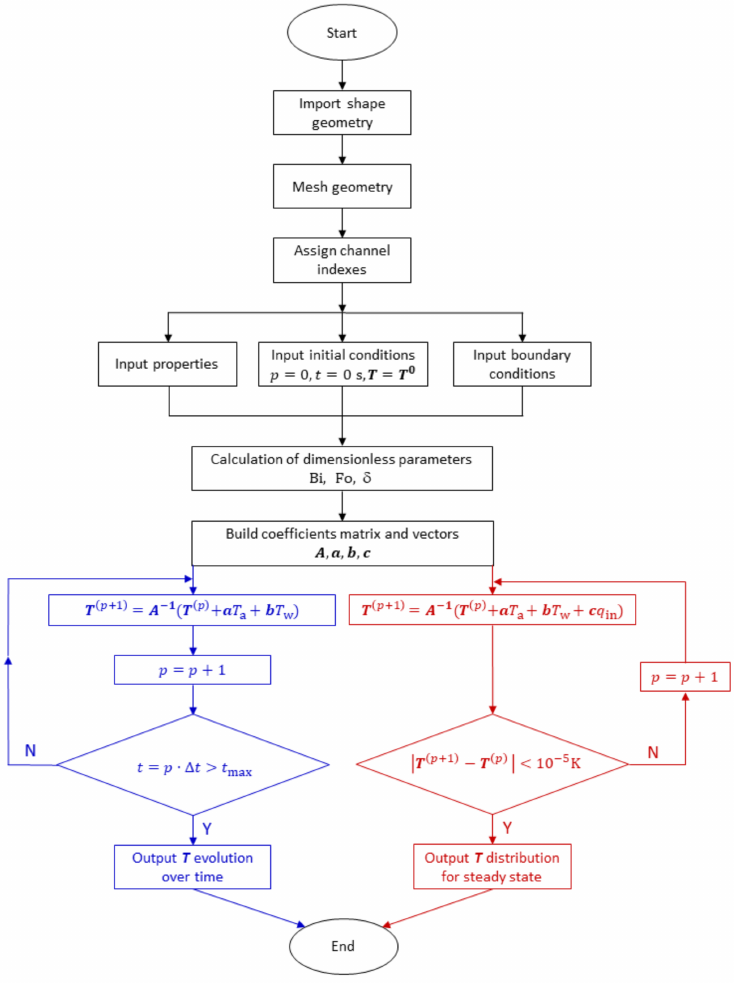
Figure 1. Flow chart of the finite difference schemes applied (blue lines correspond to the transient cooling calculations and red lines to the steady state